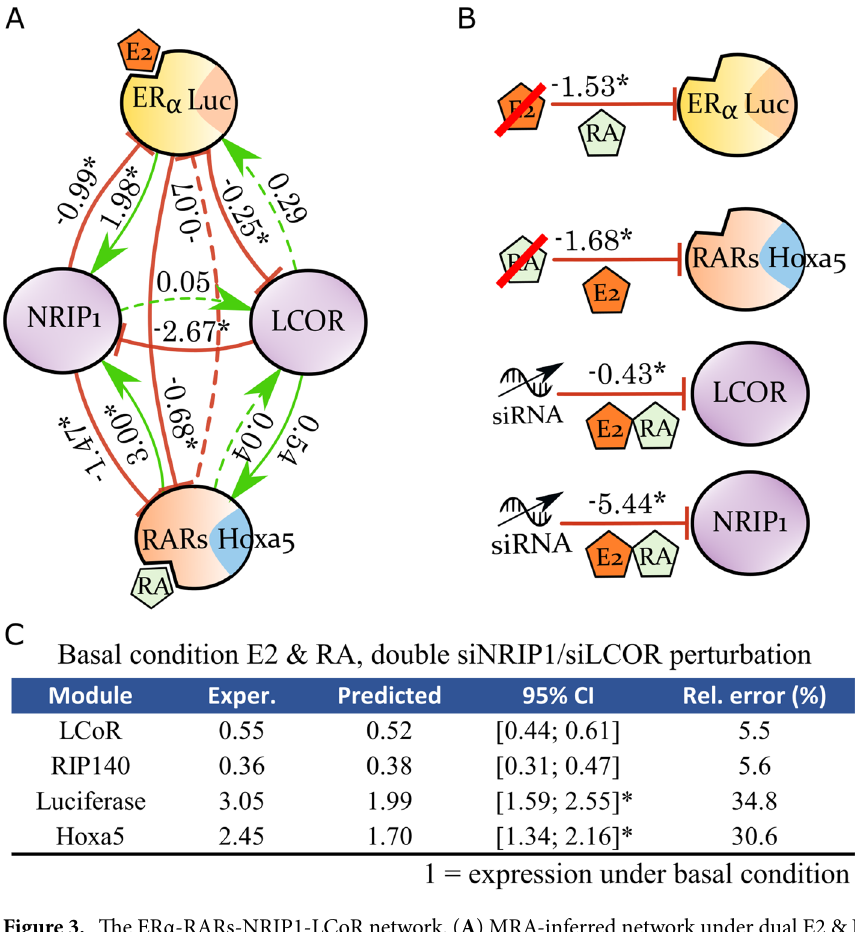
Figure 3. The ERα-RARs-NRIP1-LCoR network. ( A ) MRA-inferred network under dual E2 & RA stimulation. ( B ) Perturbation magnitudes with respect to the basal state E2 & RA stimulation (perturbations on ligands were determined by suppressing one of the two stimulations). ( C ) Predicted activity of the modules upon double siRNA inhibition of NRIP1 and LCoR. *Note that luciferase lies outside its 95% CI due to higher experimental data variability. A 98% CI equal to [1.29; 2.46] included luciferase experimental value. Figure created with Inkscape 0.92 (www. inksc ape. org) and R 3.6